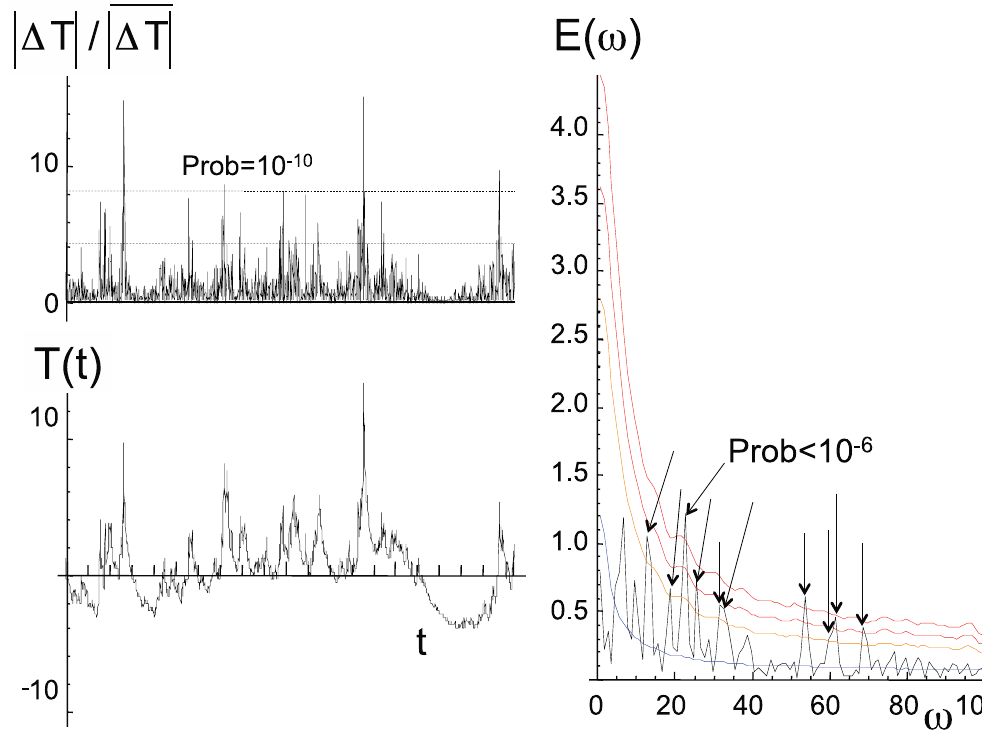
Figure 3. A multifractal simulation of a 2048 point series (lower left) with spike plot (upper left), and the corresponding spectrum (black, right). In the spike plot, the lower horizontal line corresponds to the maximum expected for a Gaussian process, the top dashed line indicates the 10 − 10 probability level. This realization was one of 5000 that were made with multifractal parameters H = 1/3, C 1 = 0.05, α = 1.8 (see Methods and Table 1). The smooth blue curve is the ensemble average of the process (with theory and numerics superposed: they cannot be distinguished). Above the blue curve, is an orange 2 standard deviation curve, and (red), 3, 4 standard deviation curves (probabilities 0.1%, 0.003% respectively). The arrows indicate spikes with Gaussian p <